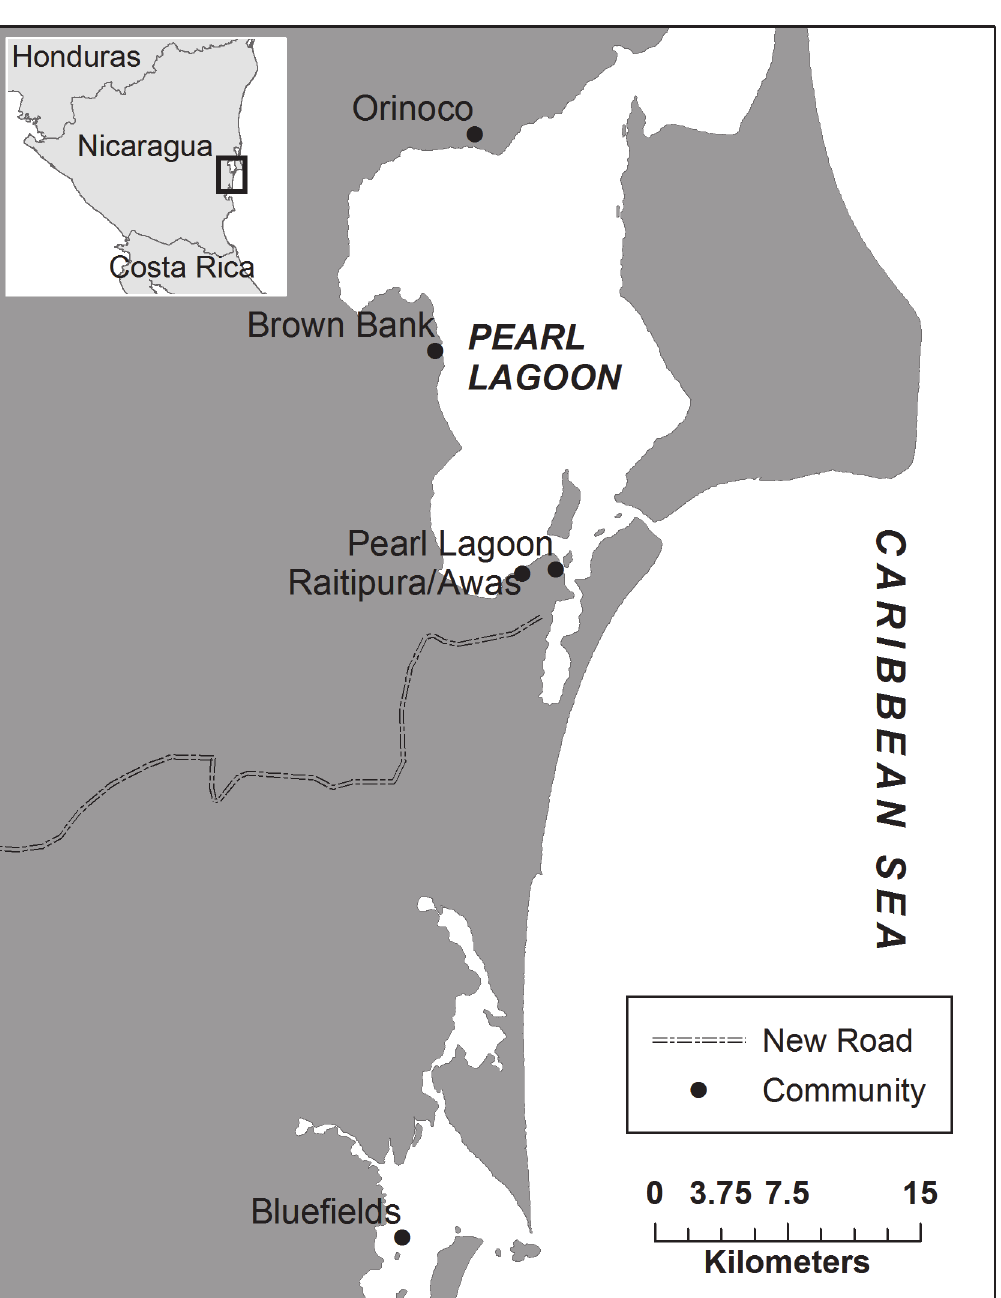
Fig 1. Nicaragua ’ s Atlantic Coast. The capital of Nicaragua ’ s Southern Autonomous Region is Bluefields. The study took place in the municipal capital north of Bluefields, Pearl Lagoon.